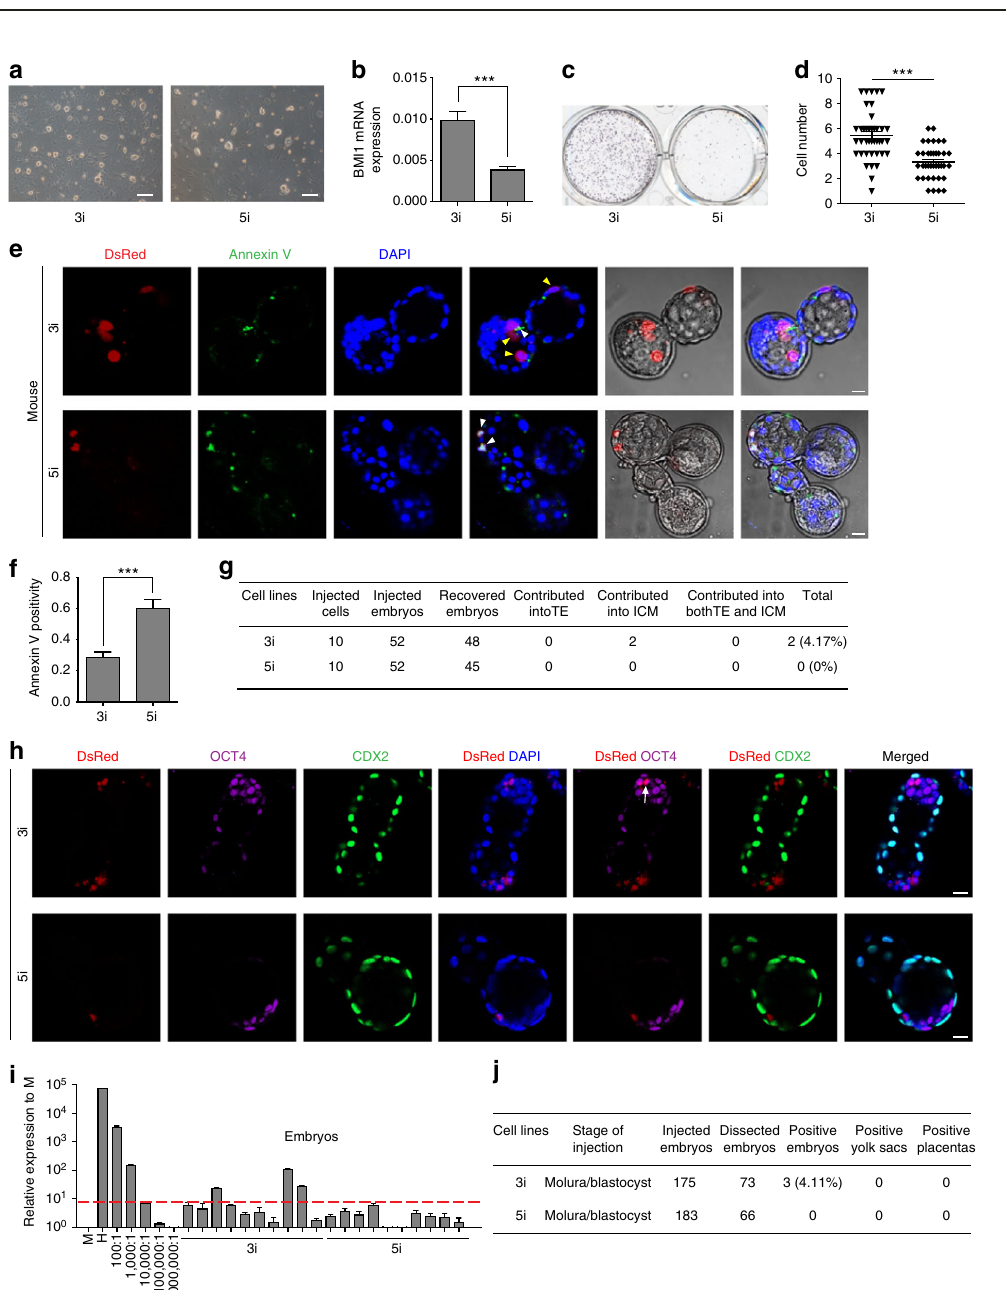
Fig. 4 hiPSCs + BMI1 integrate into rabbit and pig preimplantation blastocyst. a − d Integration of hiPSCs + BMI1 in rabbit blastocysts. a Representative images of rabbit embryos stained with Annexin V after injection of seven indicated DsRed + cells in blastocysts and 1-day culture in vitro. White arrow, DsRed + /Annexin V + cells; Yellow arrow, DsRed + /Annexin V − cells. Scale bars, 20 µ m. b Images of rabbit blastocysts injected with seven indicated cells after 1-day culture in vitro, scale bars, 50 µ m (left), 20 µ m (right). c Statistics of the percentage of engrafted DsRed + cells that were Annexin V + in the injected rabbit blastocysts; mean + SEM of 16 (UH10-DsRed) or 14 (UH10-DsRed + BMI1) samples, *** p < 0.001. d Statistics of the DsRed + cells in the injected rabbit blastocysts; mean ± SEM of 16 (UH10-DsRed) or 14 (UH10-DsRed + BMI1) samples, *** p < 0.001. e − h Integration of hiPSCs + BMI1 in pig blastocysts. e Representative images of pig embryos stained with Annexin V after injection of 3 – 5 indicated DsRed + cells in later morulas or early blastocysts for 1-day culture in vitro. White arrow, DsRed + /Annexin V + cells; Yellow arrow, DsRed + /Annexin V − cells. Scale bars, 20 µ m. f Images of pig blastocysts injected with the indicated cells after in vitro culture. Scale bars, 50 µ m (left), 20 µ m (right). g Statistics of the percentage of engrafted DsRed + cells with Annexin V + in injected pig blastocysts; mean + SEM of 16 (UH10-DsRed) or 12 (UH10-DsRed + BMI1) samples, *** p < 0.001. h Statistics of the number of DsRed + cells injected in pig blastocysts; mean ± SEM of 16 (UH10-DsRed) or 12 (UH10-DsRed + BMI1) samples, ** p < 0.01. i Representative images of pig blastocyst injected with UH10-DsRed + BMI1 stained with antibodies against the indicated markers. Two indicated DsRed + cells were injected to 8C stage pig embryos. The integrated UH10-DsRed + with BMI1 expression coexpress OCT4 or CDX2 in cultured chimeric embryos after additional 4 days ’ culture in vitro. White arrow, DsRed + /OCT4 + cells; yellow arrow, DsRed + /CDX2 + cells. Scale bars, 20 µ m. j Summary of chimera assays injected with the indicated DsRed + cells at the 8C stage pig embryo, and the injected embryos were cultured for additional 4 days